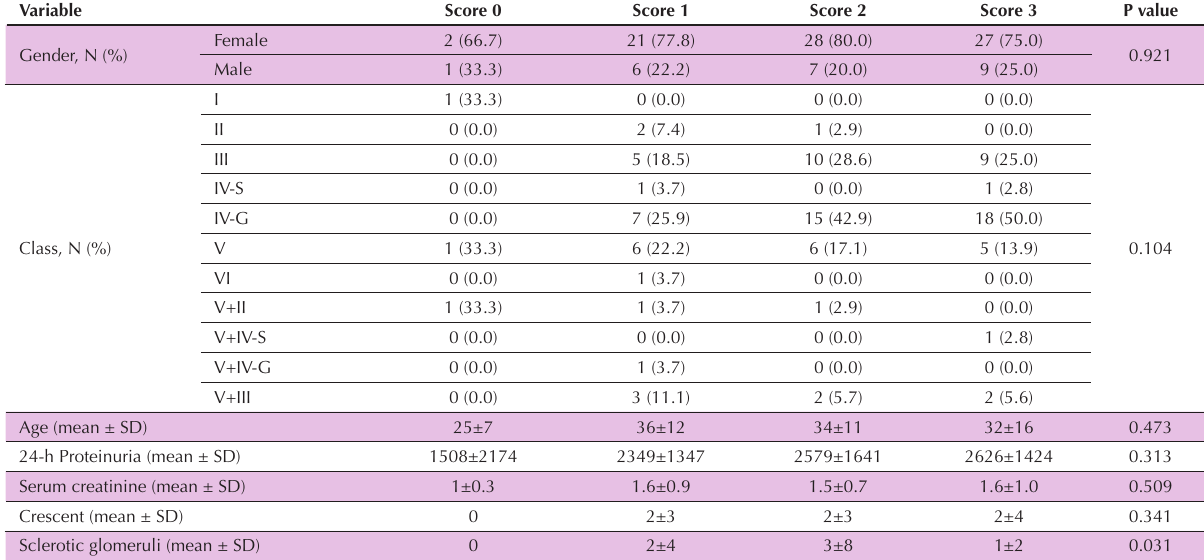
Table 5. Relationships between C1q grade and the study variables